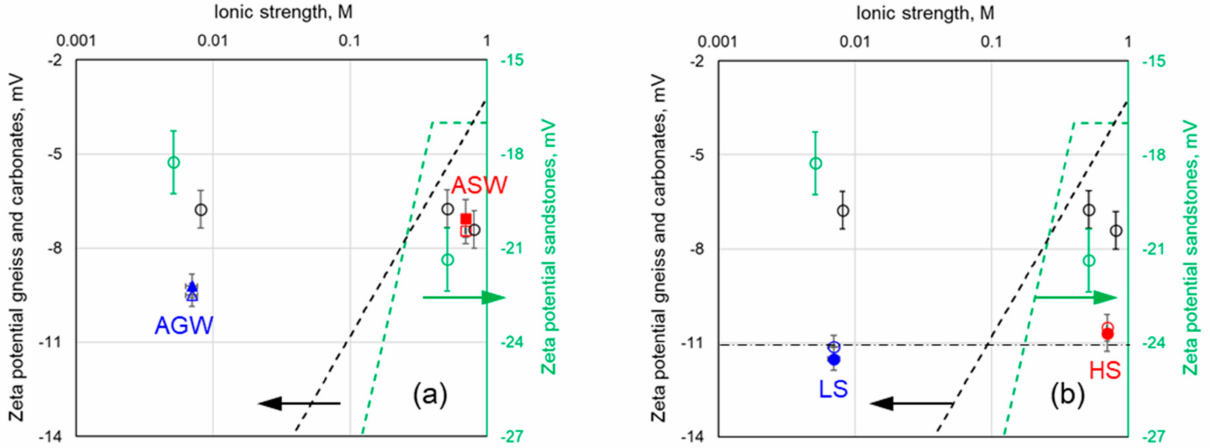
Figure 3. Impact of ionic strength on the zeta potential measured on Lewisian gneiss sample saturated with ( a ) AGW and ASW, and ( b ) with NaCl solutions. For comparison, empirical linear regressions for clean sandstones (>95% quartz; [31]) and carbonates saturated with equilibrated NaCl solutions [34] are shown in green and black dashed lines, respectively. Filled symbols correspond to the confining pressure of 7 MPa. Green circles represent zeta potentials measured in Berea sandstone saturated with NaCl solutions and averaged over seven samples (right vertical axis); the black circles correspond to results obtained with Berea sandstones saturated with CaCl 2 solutions and averaged over six samples [45].